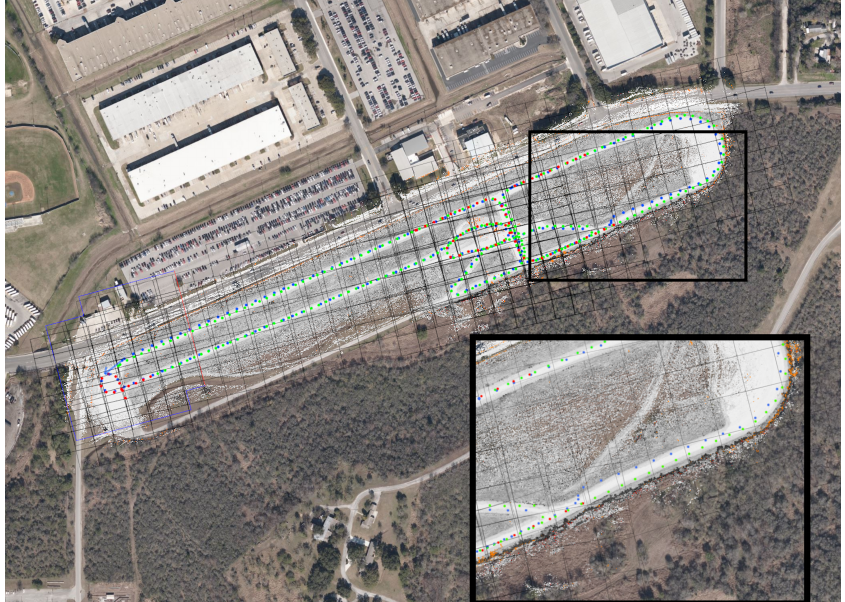
Figure 4. The persistent map (costmap layer) with GPS dropouts throughout the entire map. The avail- able GPS measurements are shown in red, the odometric data in blue. The inset image is a magnified portion of the southwest portion of the left image, showing where GPS was restored as the vehicle traveled west. The satellite imagery and GPS coordinates (green dots) are shown only for context, and are not available to the system.